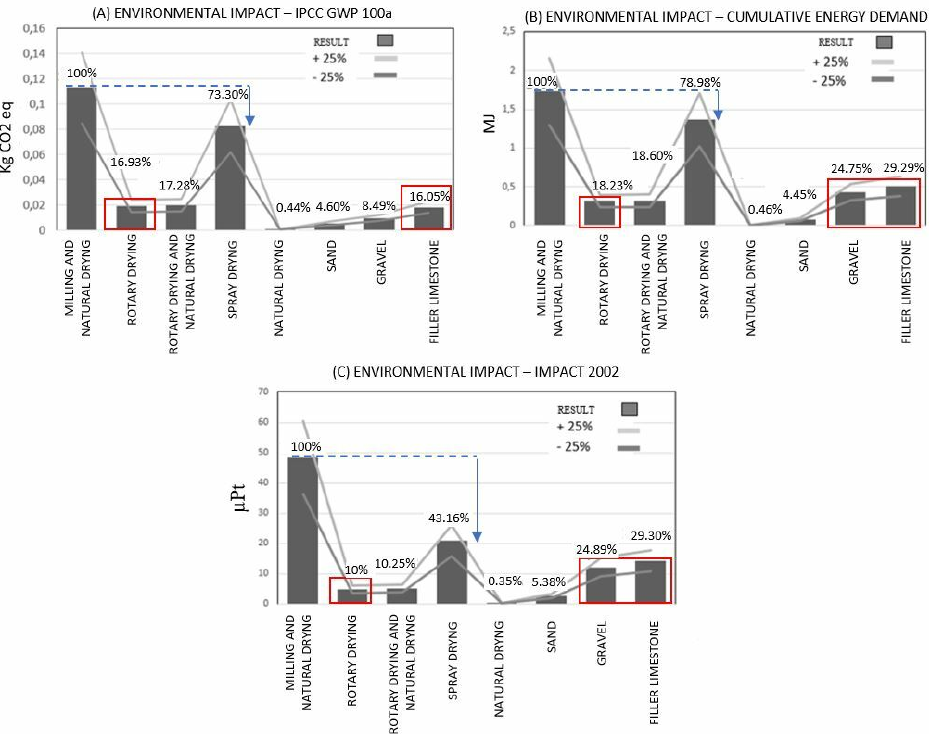
Figure 13. Environmental impact per 1 kg of material: ( A ) global warming potential (GWP) indicator; ( B ) cumulative energy demand; ( C ) total environmental impact (IMPACT 2002+).